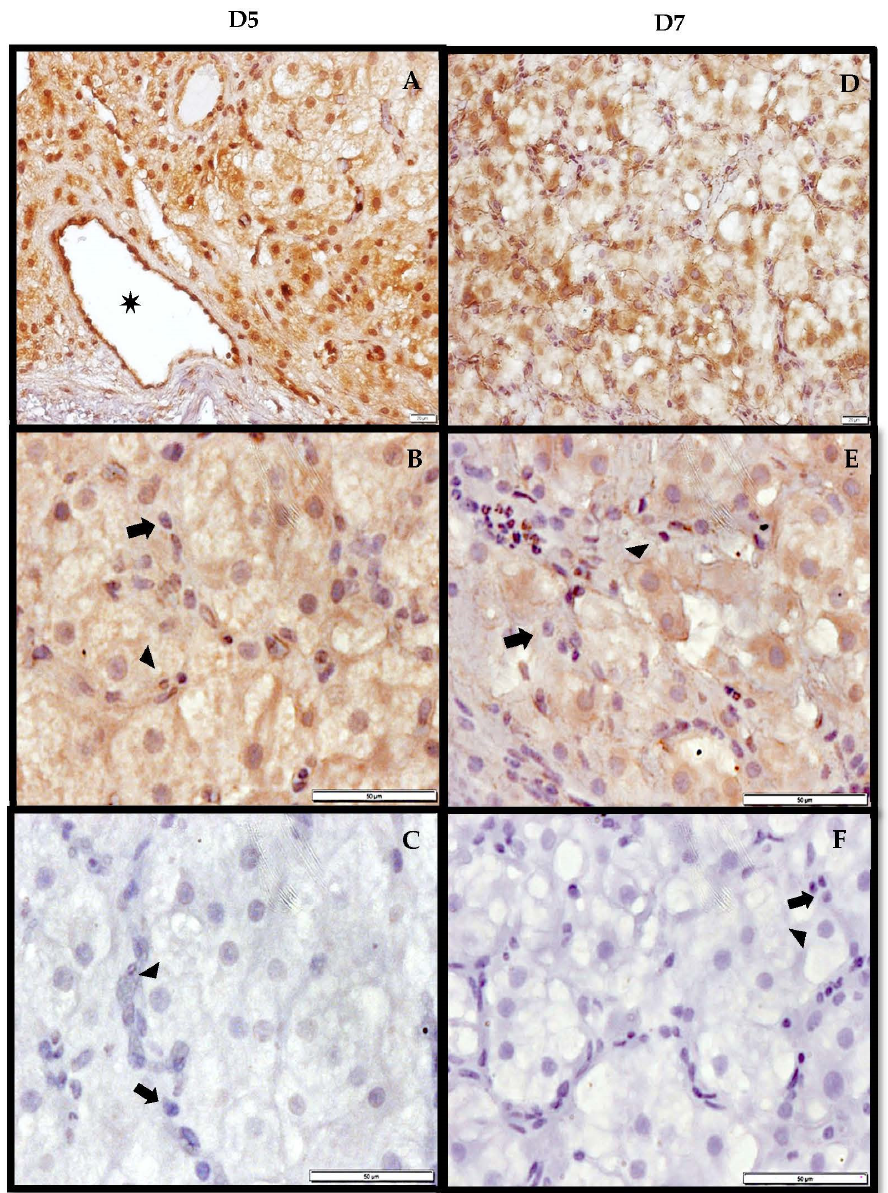
Figure 5. Representative immunohistochemistry of AdipoR2 in a D5 ( A – C ) and D7 ( D – F ) CL using NovaRED ® (Vector Laboratories) and stained with hematoxylin. Panels A and D are 20 × magnifica- tion of the tissue section. Panels B and E are 40 × magnification of tissue sections A and D, respectively. Panels C and F are 40 × magnification of tissue sections incubated in normal serum. Star indicates vessel, black arrow points to small luteal cells, and black arrowhead points to large luteal cells. Scale bar is 20 μ m in 20× magnification panels and 50 μ m in 40× magnification panels.